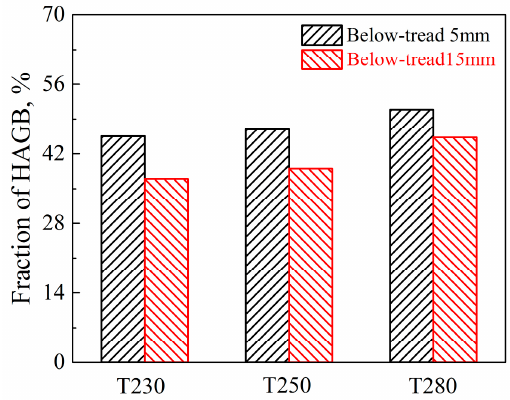
Figure 7. Fraction of high-angle (>15°) grain boundaries (HAGBs).